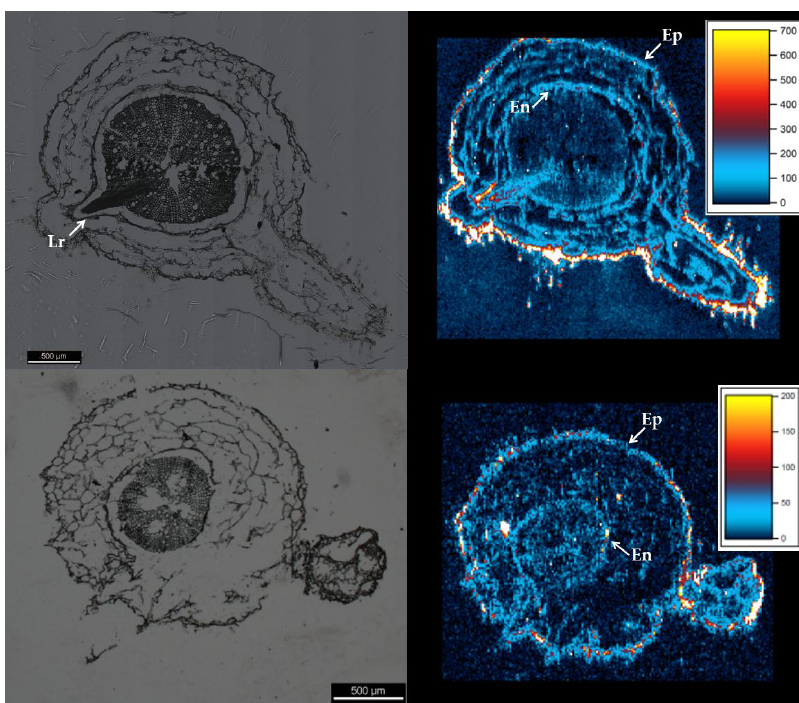
Figure 2. Micrographs ( left ) and laser ablation inductively-coupled plasma mass spectrometry (LA-ICP-MS) maps ( right ) of root cross-sections collected from root samples from ( top ) 76R and ( bottom ) rmc tomato plants. Color bars inset in LA-ICP-MS maps show relationship between counts per second (CPS) and color for each map. Ep = epidermis. En = endodermis. Lr = lateral root.